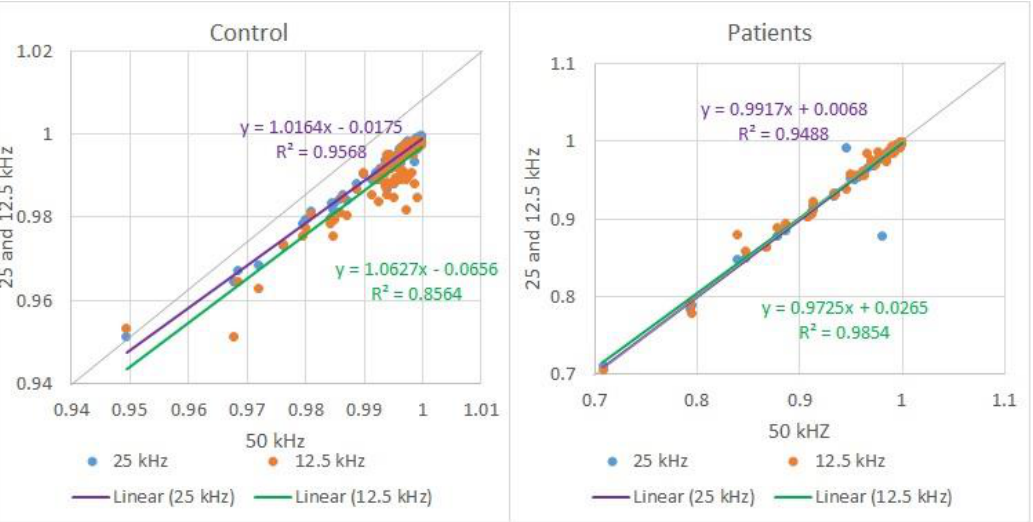
Figure 8. Comparative analysis of the Autocorrelation with 25 and 12.5 kHz over 50 kHz sampling frequency.